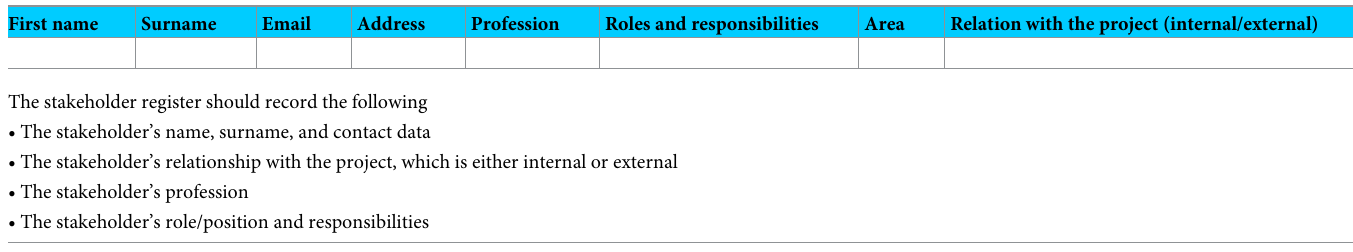
Table 1. Example stakeholder register.